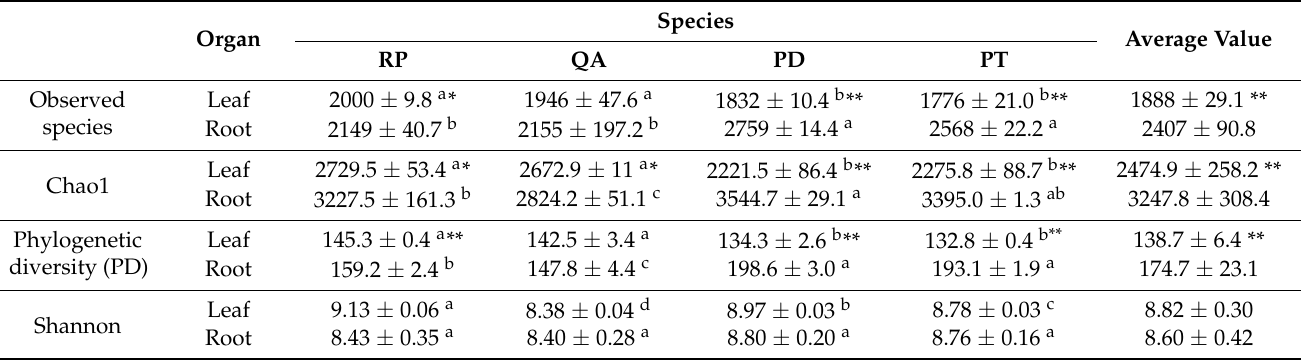
Table 3. Bacterial alpha diversity indices in litter after fine root and leaf litter decomposition for one year at Mount Tai.